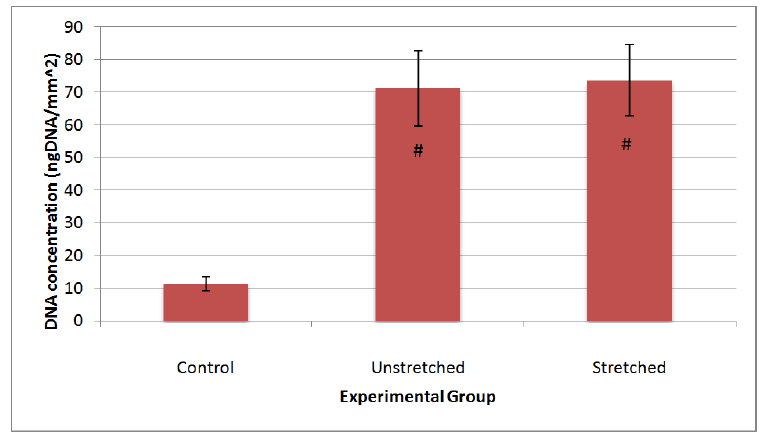
Figure 8. DNA concentration of each experimental group. Data from all three sections of each scaffold were combined to compare the effect had over the whole scaffold. n = 5. Error bars represent one standard deviation. # Statistically different than control ( p < 1 × 10 − 6 ).